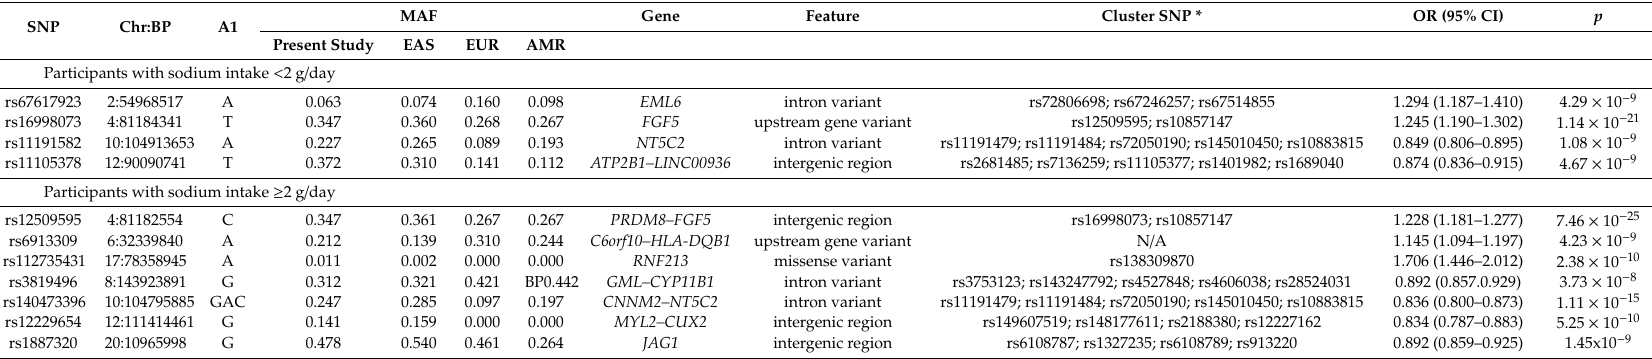
Table 2. Single-nucleotide polymorphisms (SNPs) most strongly associated with hypertension susceptibility loci in the Korean population, according to sodium